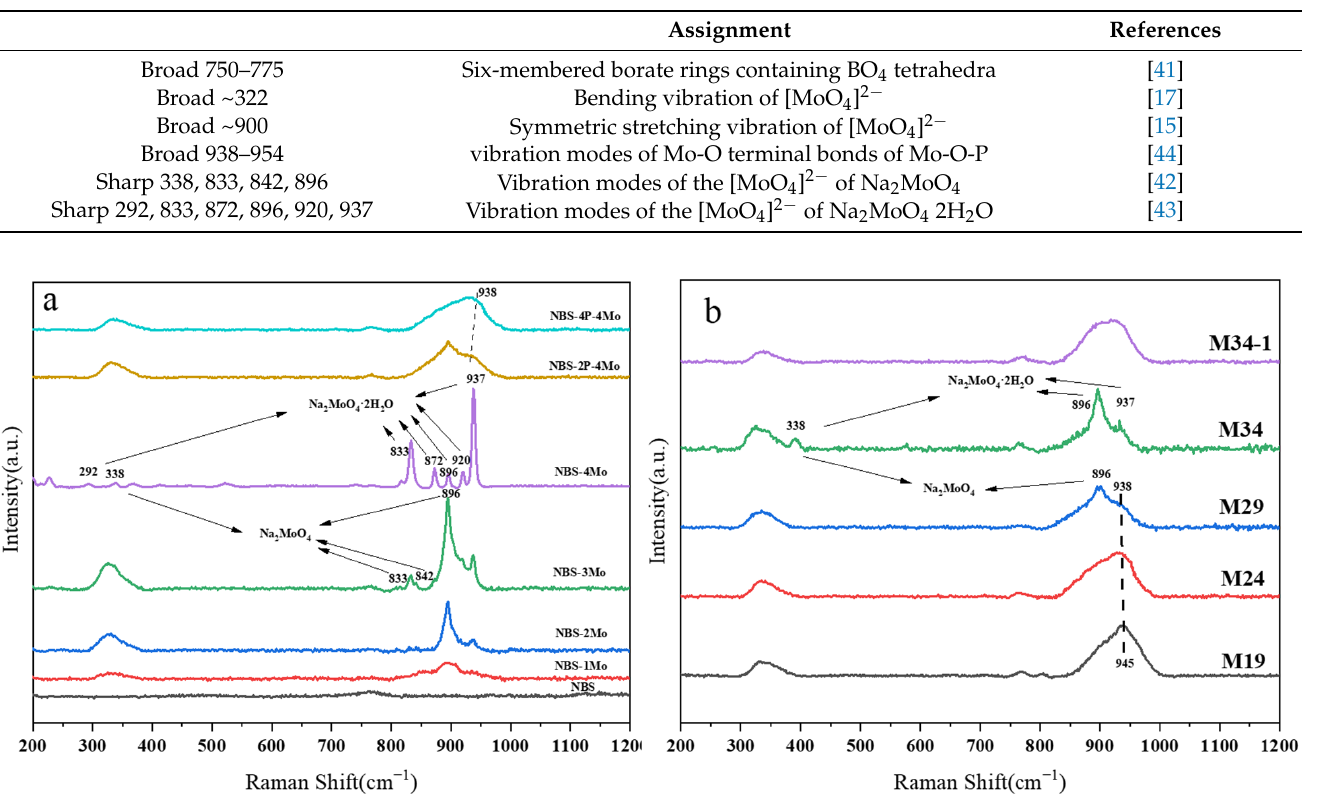
Table 2. Assignments of the bands in the observed Raman spectra.